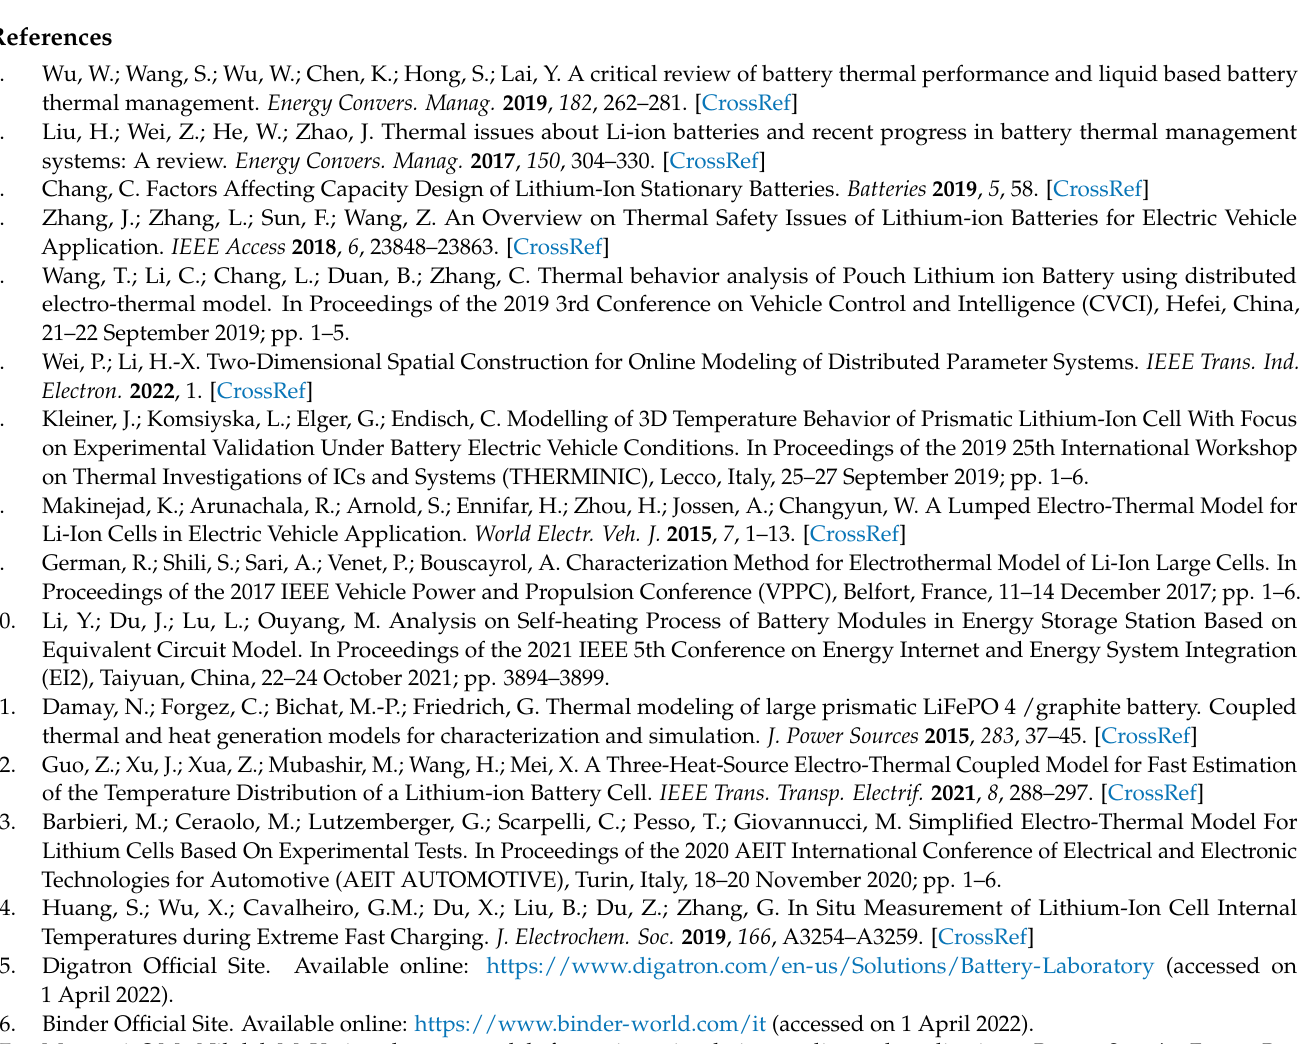
Figure A1. WLTC current I 1 (top) and I 2 (bottom) profiles, test 1 solicitation.